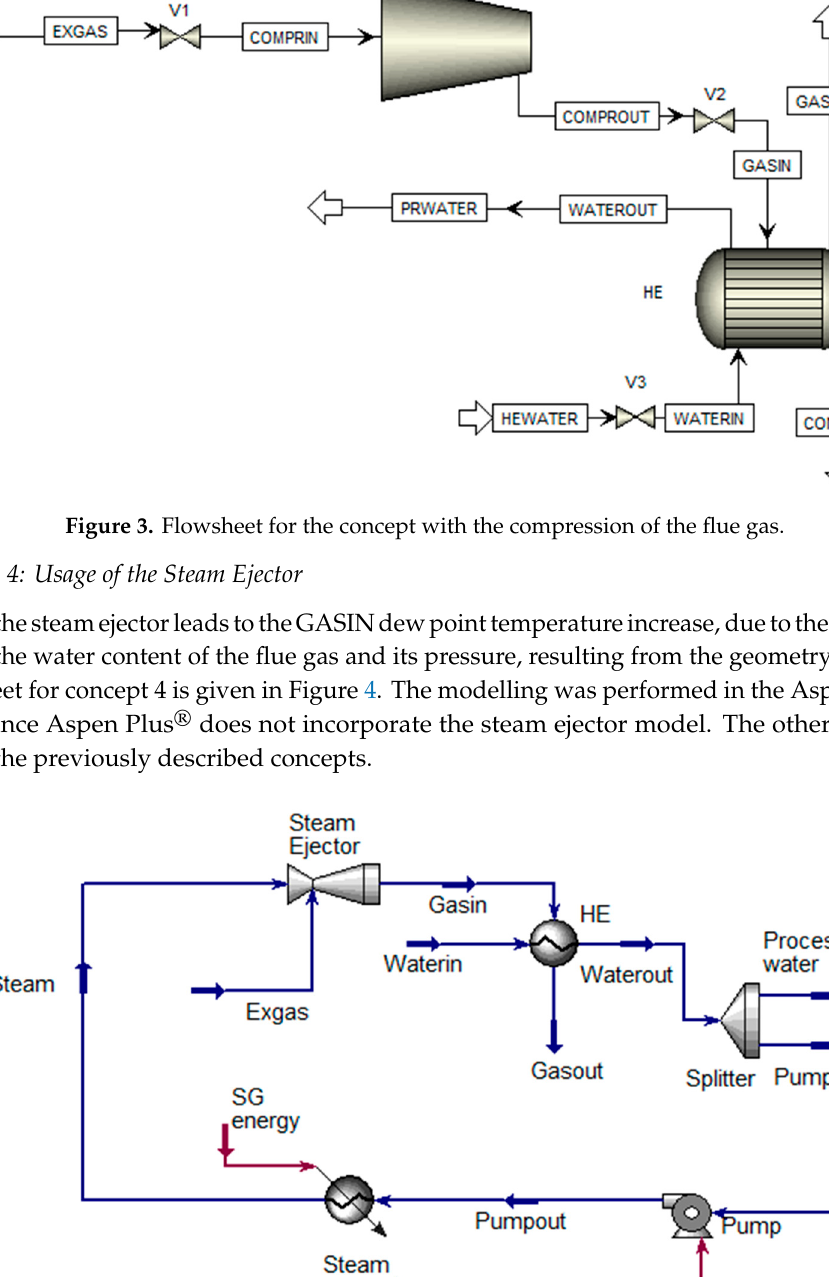
Figure 2. Flowsheet for the humidification of the flue gas using steam.